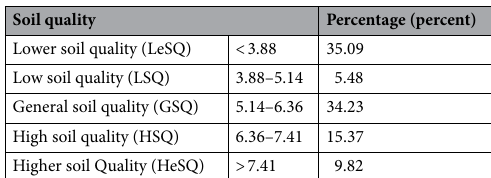
Table 5. The soil quality and its proportion in the QTP (percent).